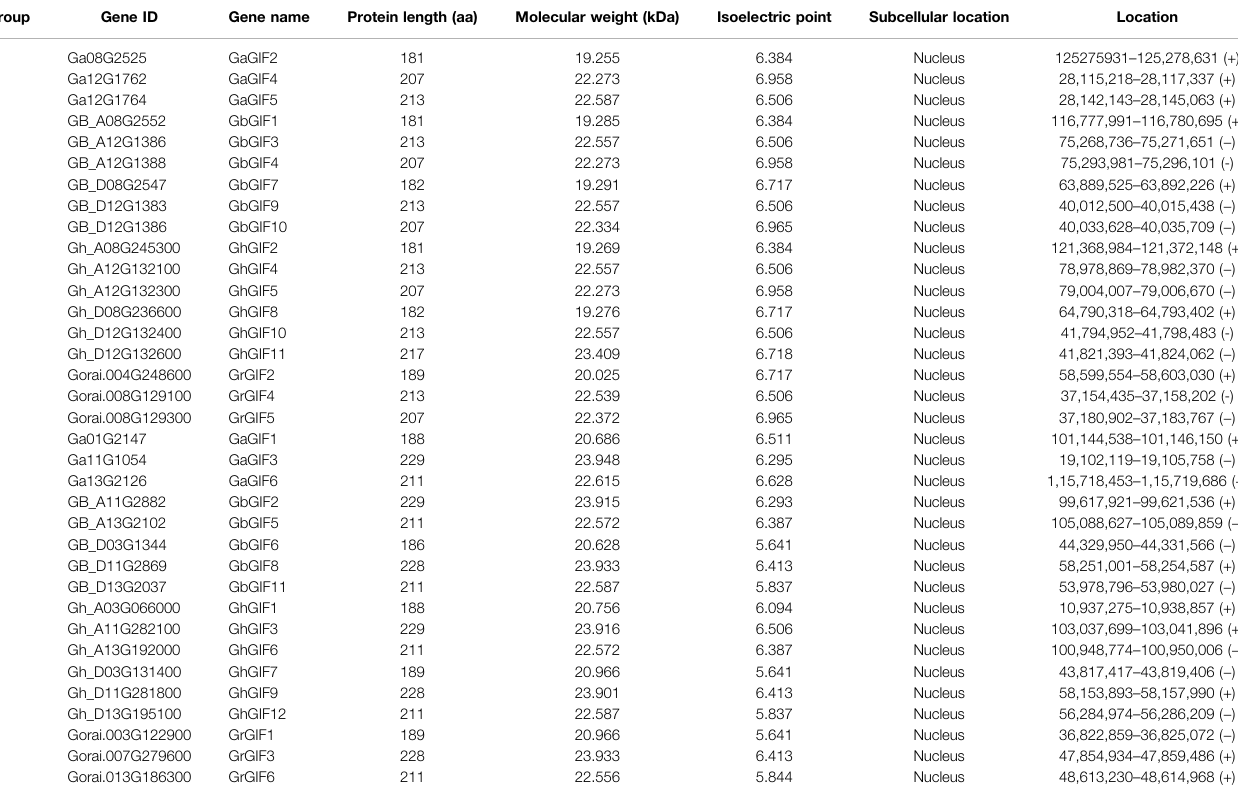
TABLE 1 | Characteristics of the putative cotton GIF